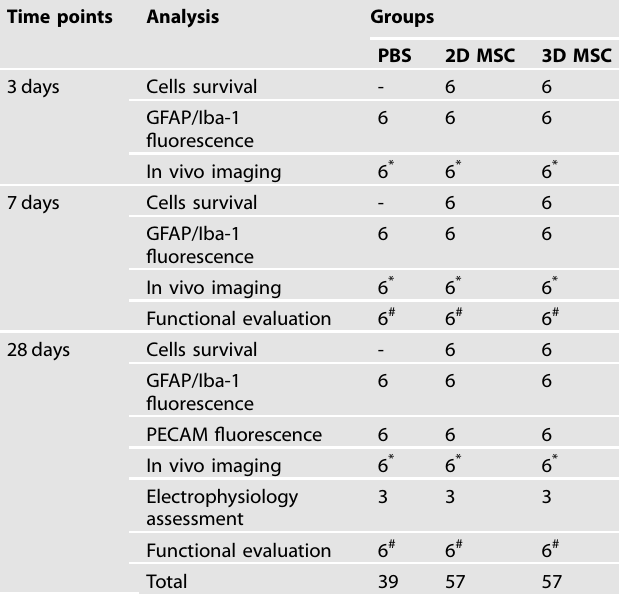
Table 2. Experimental